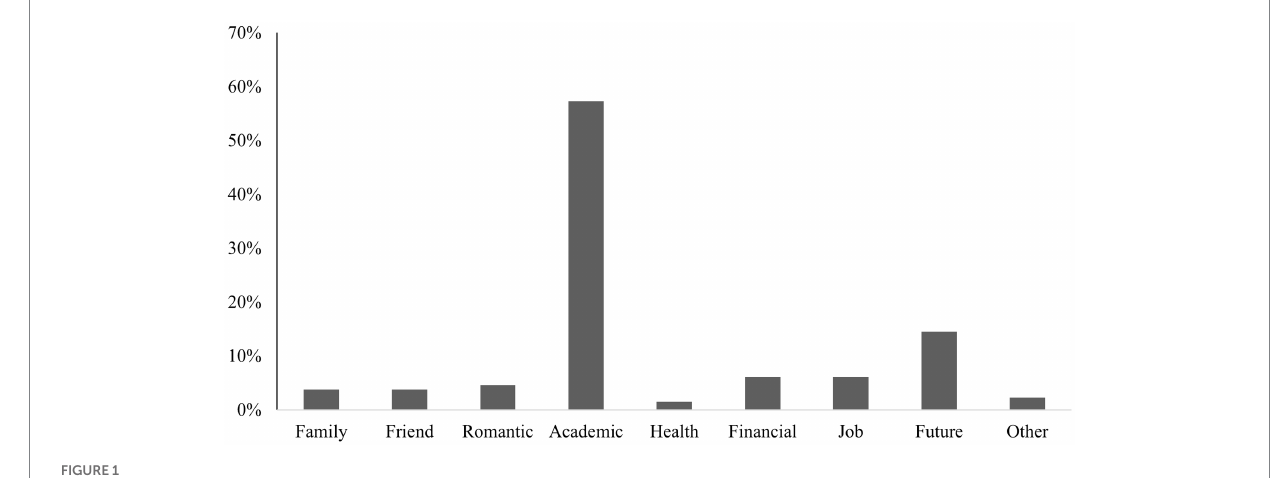
FIGURE 1 Stressors of Chinese international students in